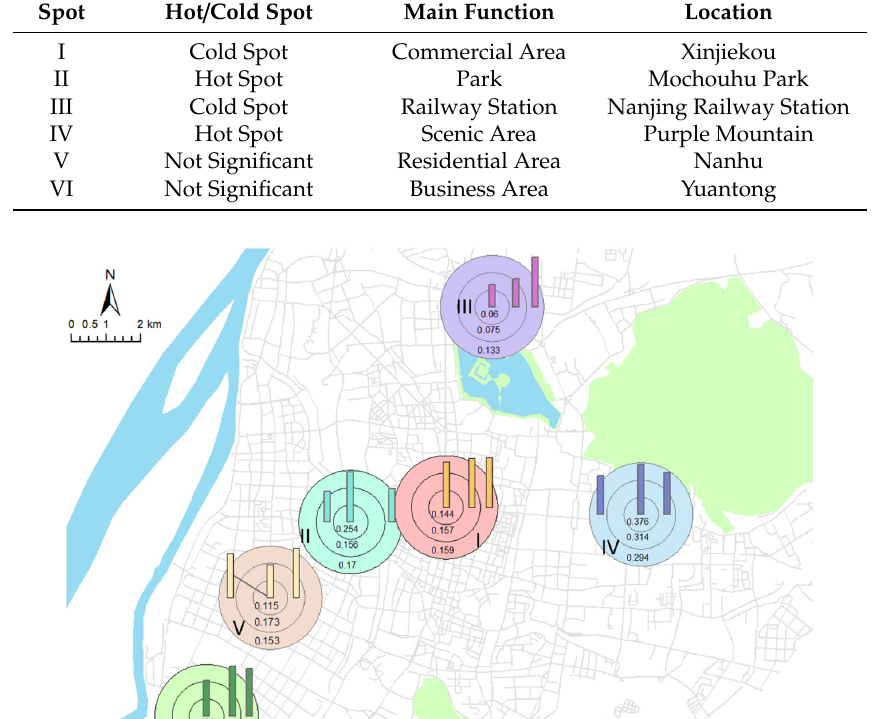
Figure 9. GVI variation trend from the inner ring to the outer ring in 6 spots (I–VII). The horizontal axis represents three buffer rings. The vertical axis represents the average GVI in each ring.